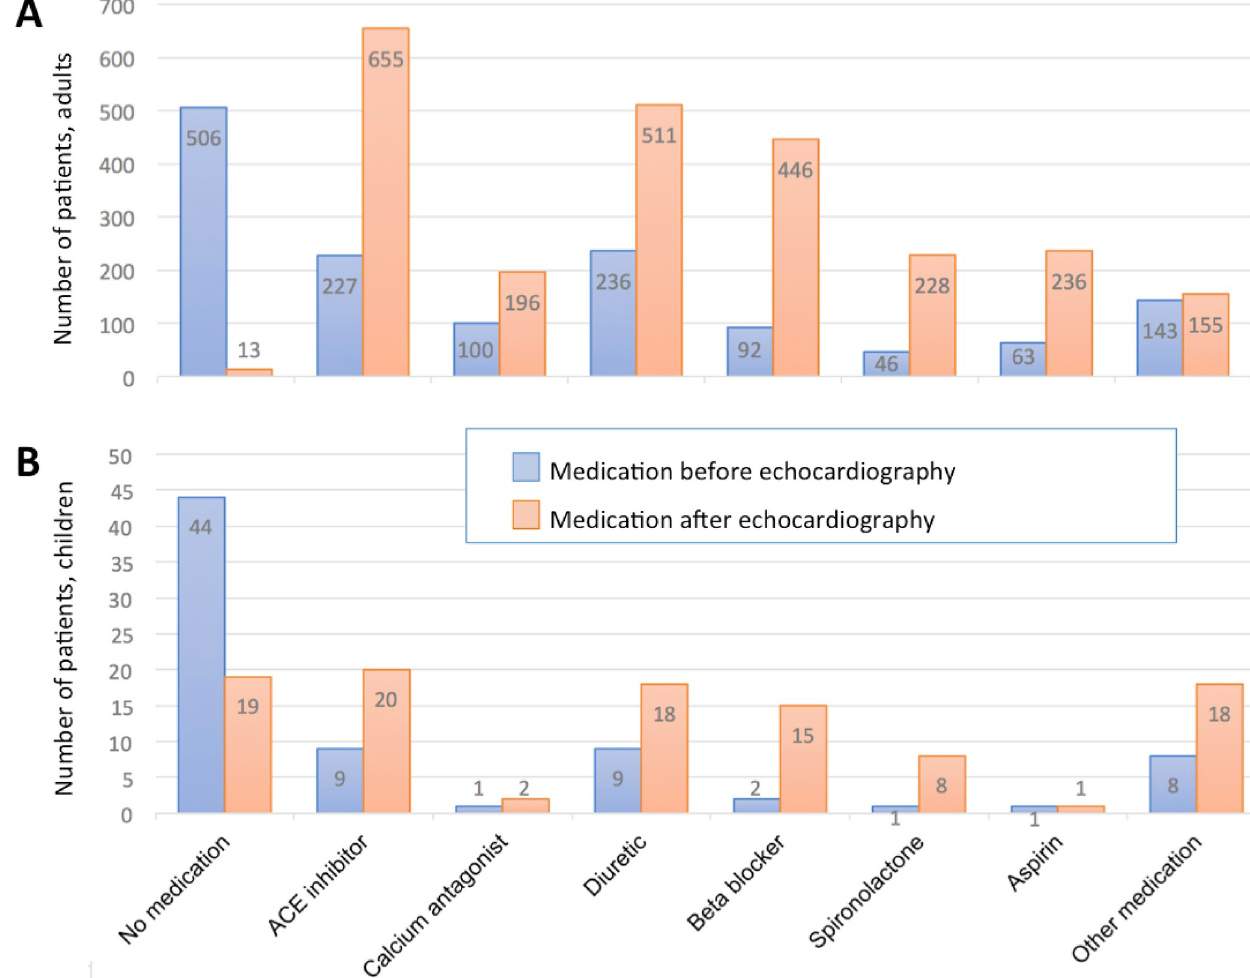
Fig 2. Medication taken before and prescribed after echocardiography in adults (A) and in children (B).